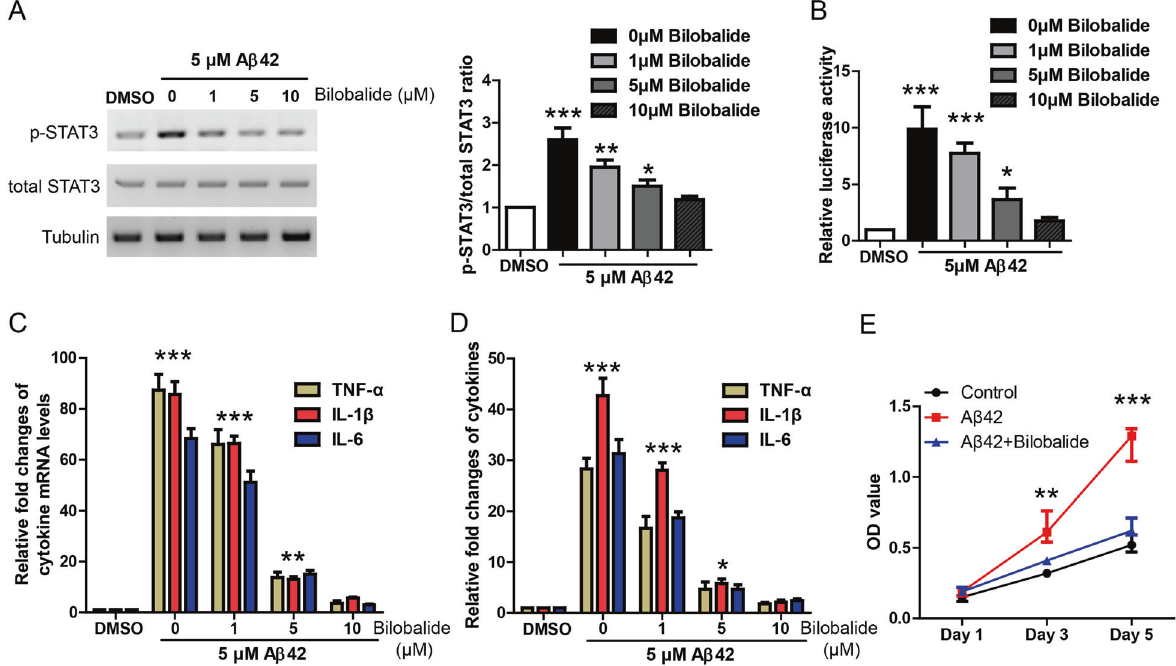
Fig. 2 Bilobalide inhibits STAT3-dependent in fl ammation responses in A β 42-treated astrocyte culture. A Western blot and its quanti fi cation showing STAT3 protein levels in astrocyte culture treated by 5 μ M A β 42 and bilobalide at indicated concentrations. B STAT3 luciferase reporter assay showing STAT3 transcription activity in astrocyte culture treated by 5 μ M A β 42 and bilobalide at indicated concentrations. C Quantitative real-time PCR results showing the levels of TNF- α , IL-1 β , and IL-6 in the astrocyte culture treated by 5 μ M A β 42 and bilobalide at indicated concentrations. D ELISA results showing the levels of TNF- α , IL-1 β , and IL-6 in the astrocyte supernatant under the treatment of 5 μ M A β 42 and bilobalide at indicated concentrations. E CCK-8 assay showing the astrocyte proliferation under the treatment of 5 μ M A β 42 and bilobalide at indicated concentrations. * P < 0.05, ** P < 0.01, *** P <